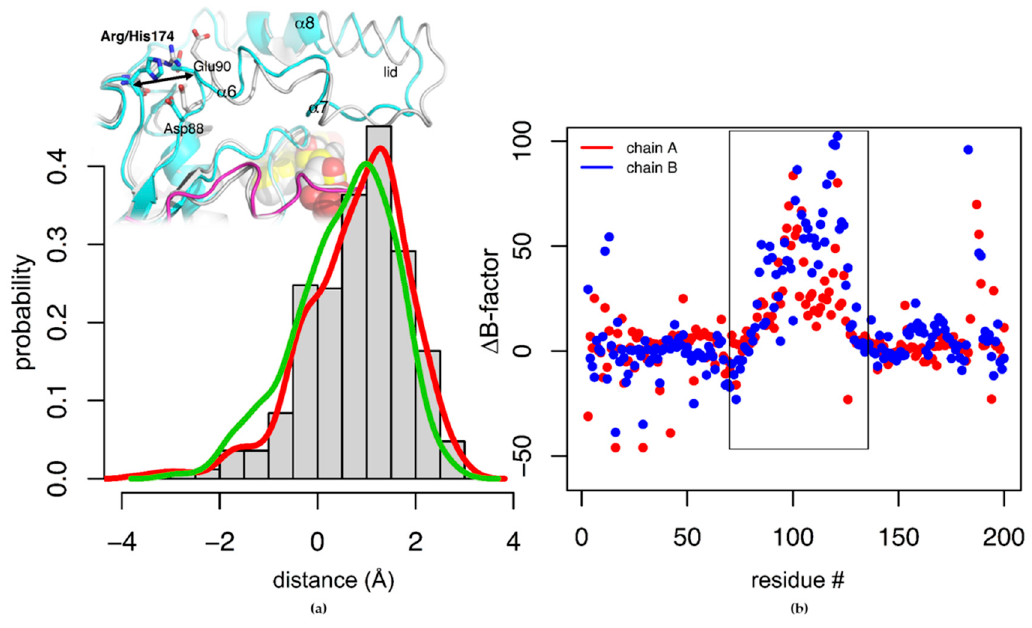
Figure 7. ( a ) Histogram of the difference between distances of alpha carbons of residues Arg/His174 and Glu90 in variant K166/R174/Y194 with respect to K166/H174/Y194 along the MD simulations at 363 K. Both active sites A (red line) and B (green line) are shown. ( b ) B-factor differences per residue along with the MD simulations at 363 K, defined as B-factorKRY-B-factorKHY. A more positive value indicates a more mobile residue along with the MD